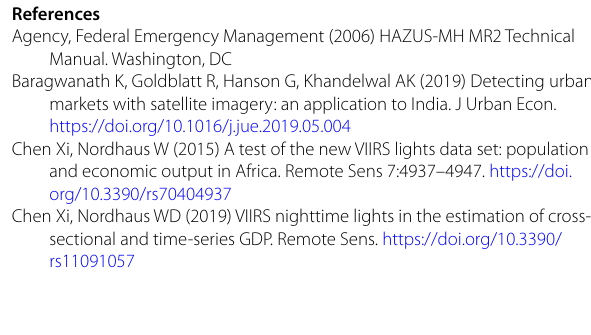
amount of noise and cloud cover in the underlying VIIRS data some caution is in order. Potential future research within the area could focus on other large-scale earthquakes or natural hazard types as the methodology is easily scaled and depends on few inputs. Another option is to explore other algo- rithms or secondary data to potentially achieve more consistent and comparable nightlight measurements.